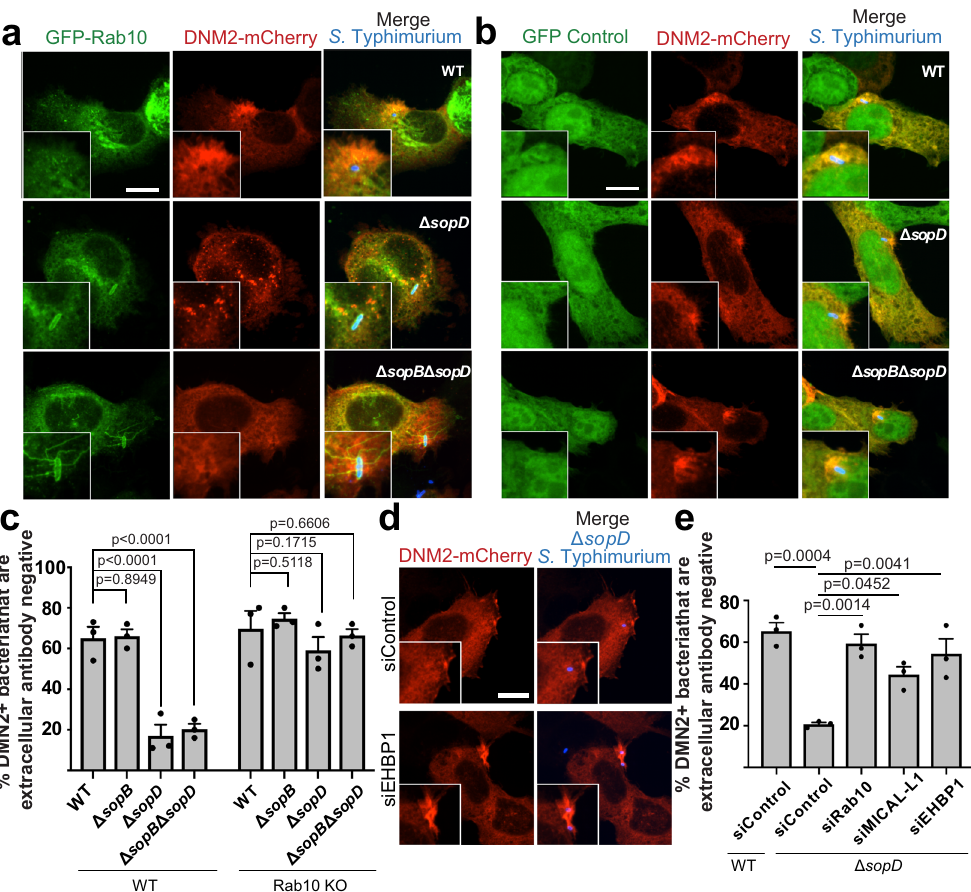
Fig. 5 Rab10 and its effectors inhibit recruitment of Dynamin-2 during invasion by Δ sopD mutant S . Typhimurium. a Representative image of WT Henle 407 cells that were transfected with GFP-Rab10, and DNM2-mCherry then infected with WT, Δ sopD , or Δ sopB Δ sopD S . Typhimurium SL1344 for 30